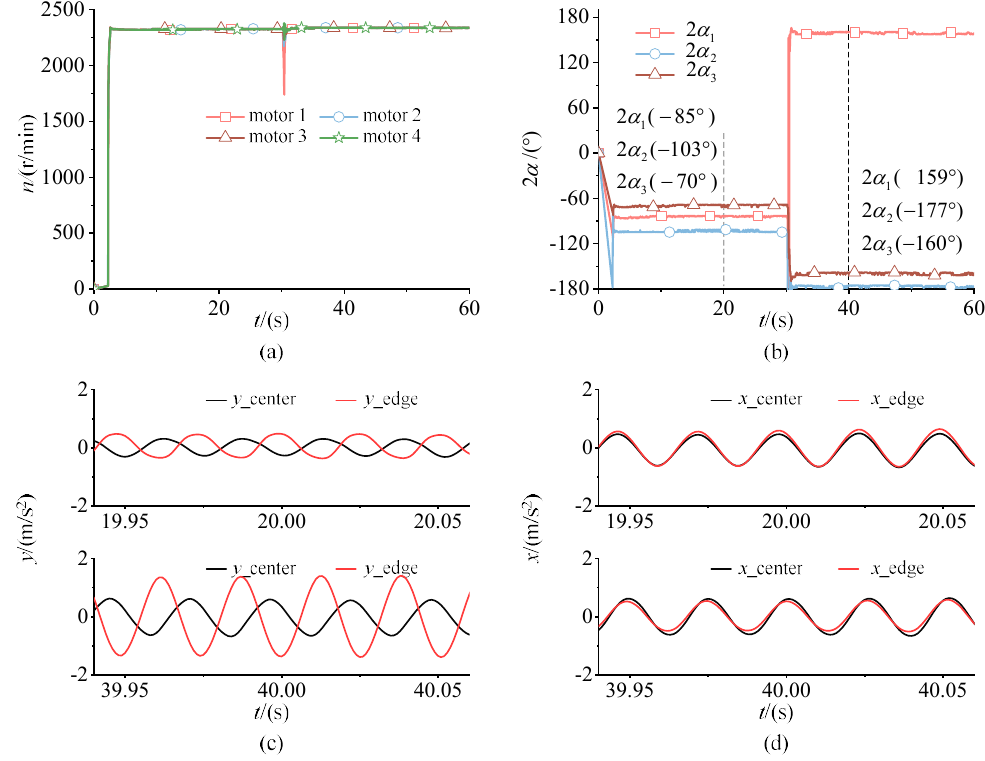
Figure 8. Phase images of 90 ◦ in super-resonance during one period of motion.